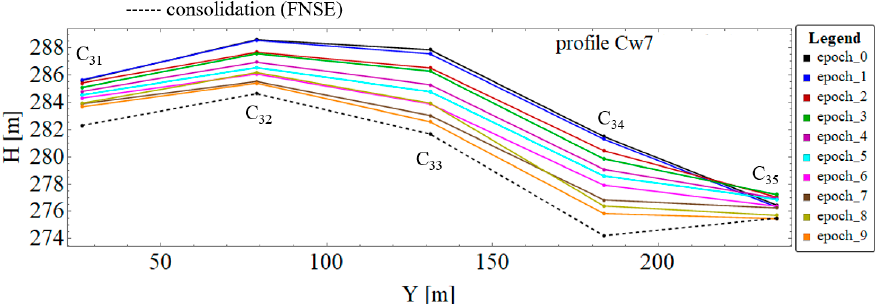
Figure 11. Calculated centroid height by profile Cw7, including height at predicted consolidation using the FNSE model.